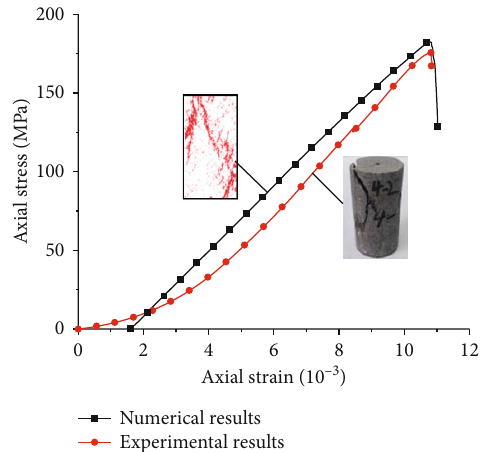
Figure 5: Comparison between experimental and numerical stress- strain curves and failure mode of the intact specimen.